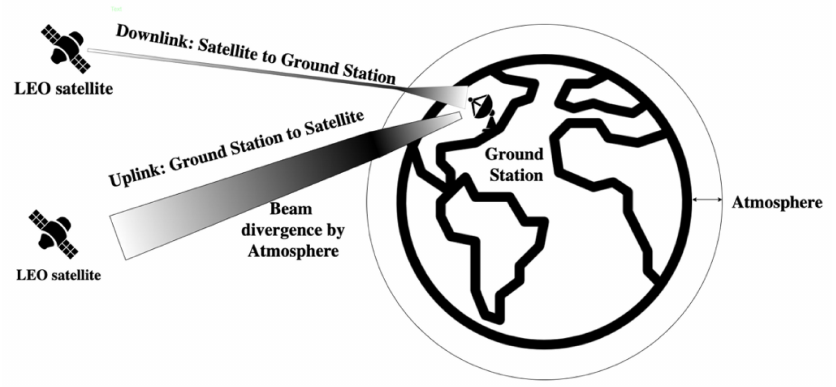
Figure 2. Beam divergence in satellite − ground FSO communications for both uplink and downlink